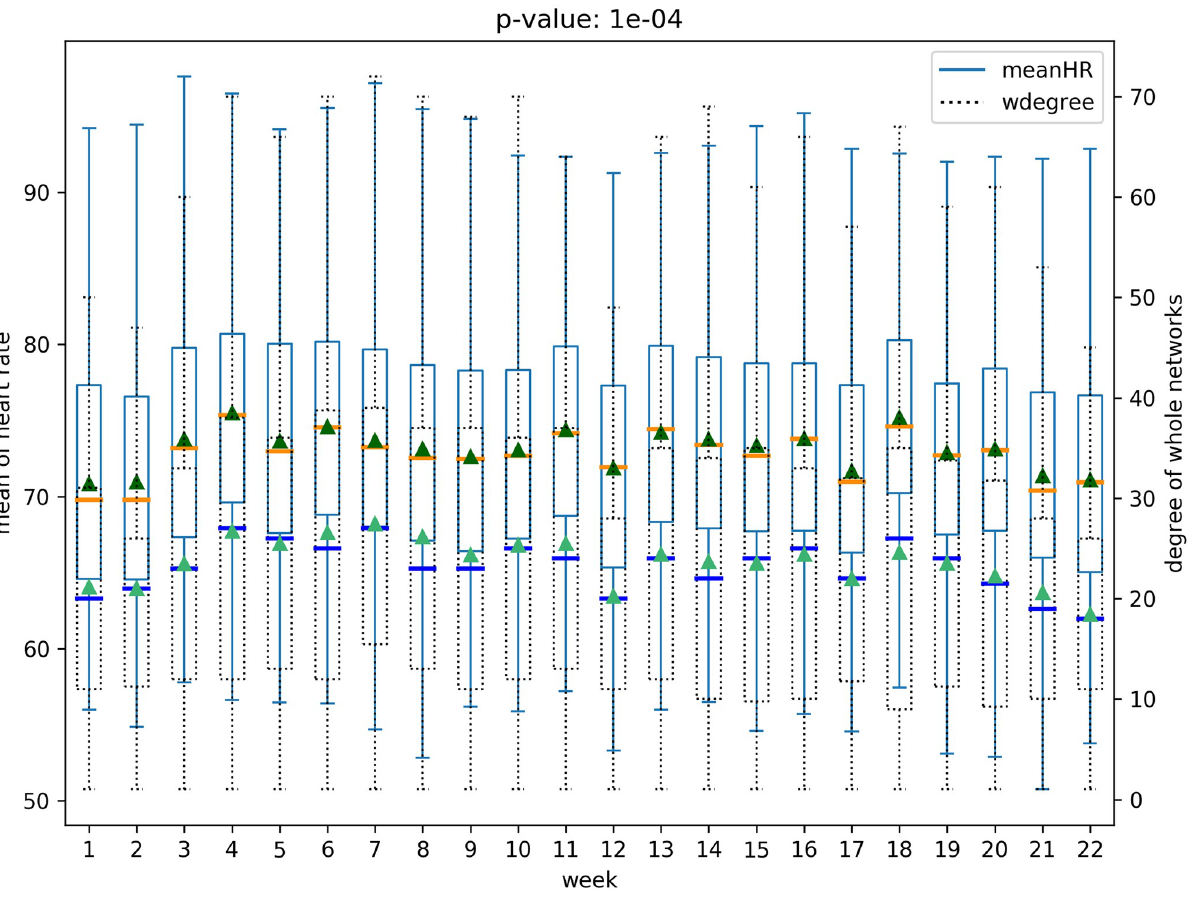
Fig 7. Relation between heart rate and degree of whole network